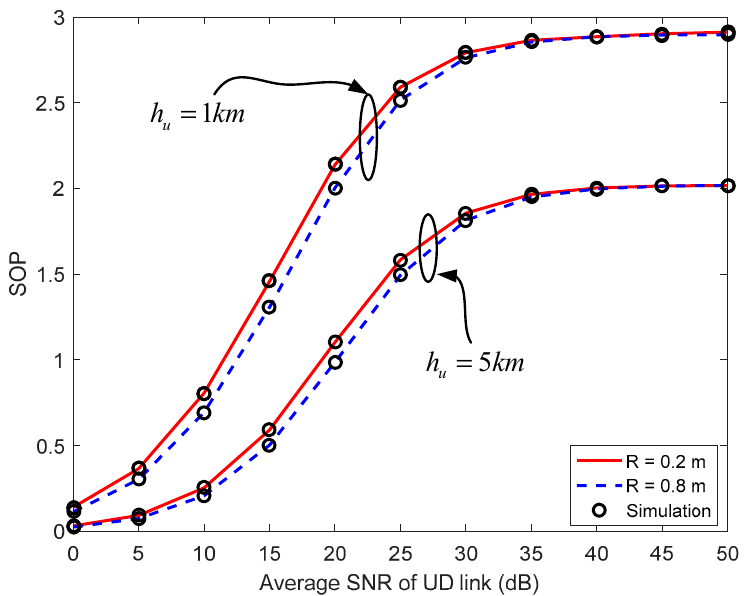
Figure 9. Impact of h u on the ASC performance at different values of R when γ BU = 25 dB, γ UE = 10 dB, and ρ e = 3 × 10 − 6 .